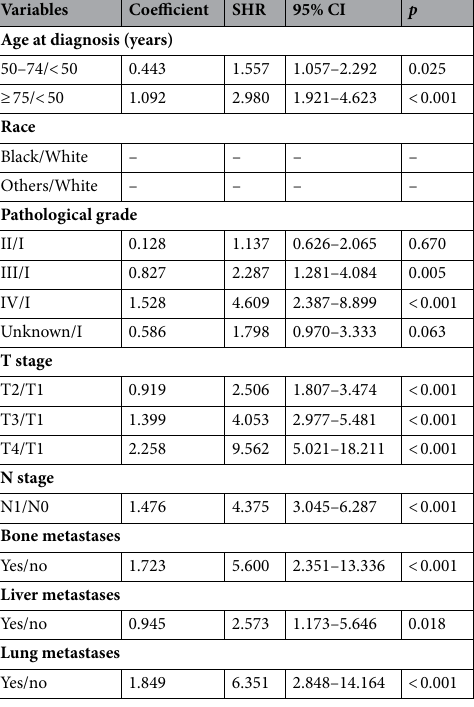
Table 2. Multivariable competing risk analysis for CSM. CSM cancer-specific mortality, CI confidence interval, sHR subdistribution hazard